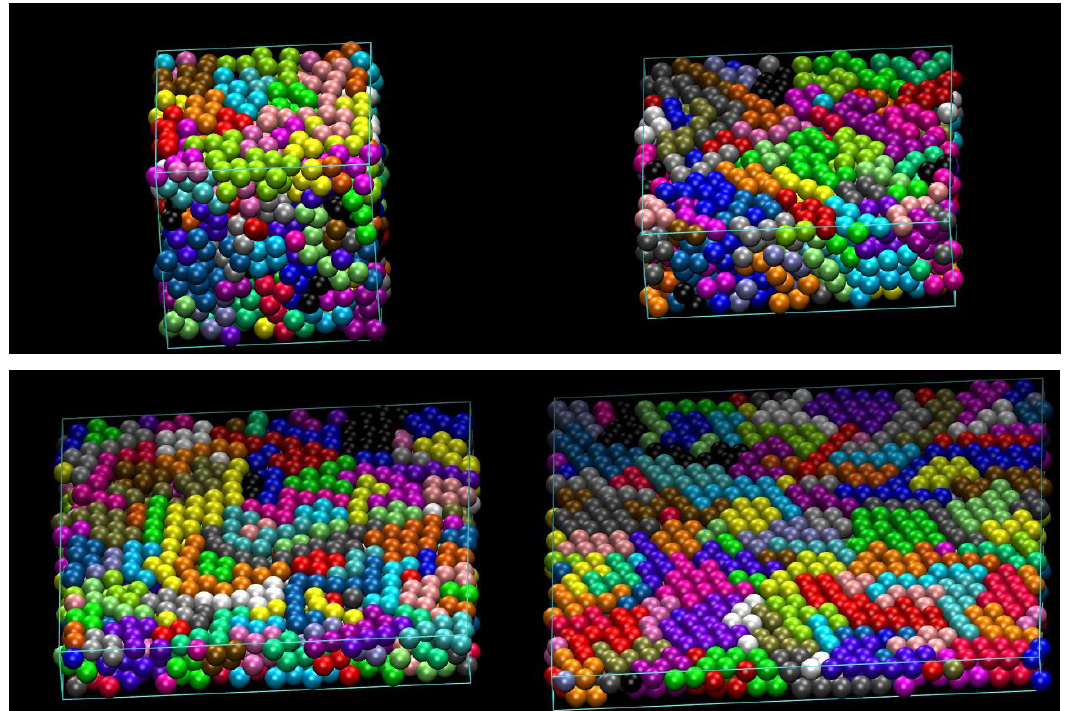
Figure 3. Snapshots of the 100-chain N mon = 12 hard sphere system at ϕ = 0.50 and under unidimensional confinement ( d conf = 1) for various cell aspect ratios, ζ , corresponding to plate-like geometries. From left to right and from top to bottom: ζ = 1 (10.8), 3 (5.2), 7 (3.0) and 12 (2.0). Number in parenthesis indicates the inter-wall distance in the direction of confinement (in units of sphere diameter). Sphere monomers are color-coded according to the parent chain. Image panels created with the VMD software [134]. (please see supplementary materials for 3D